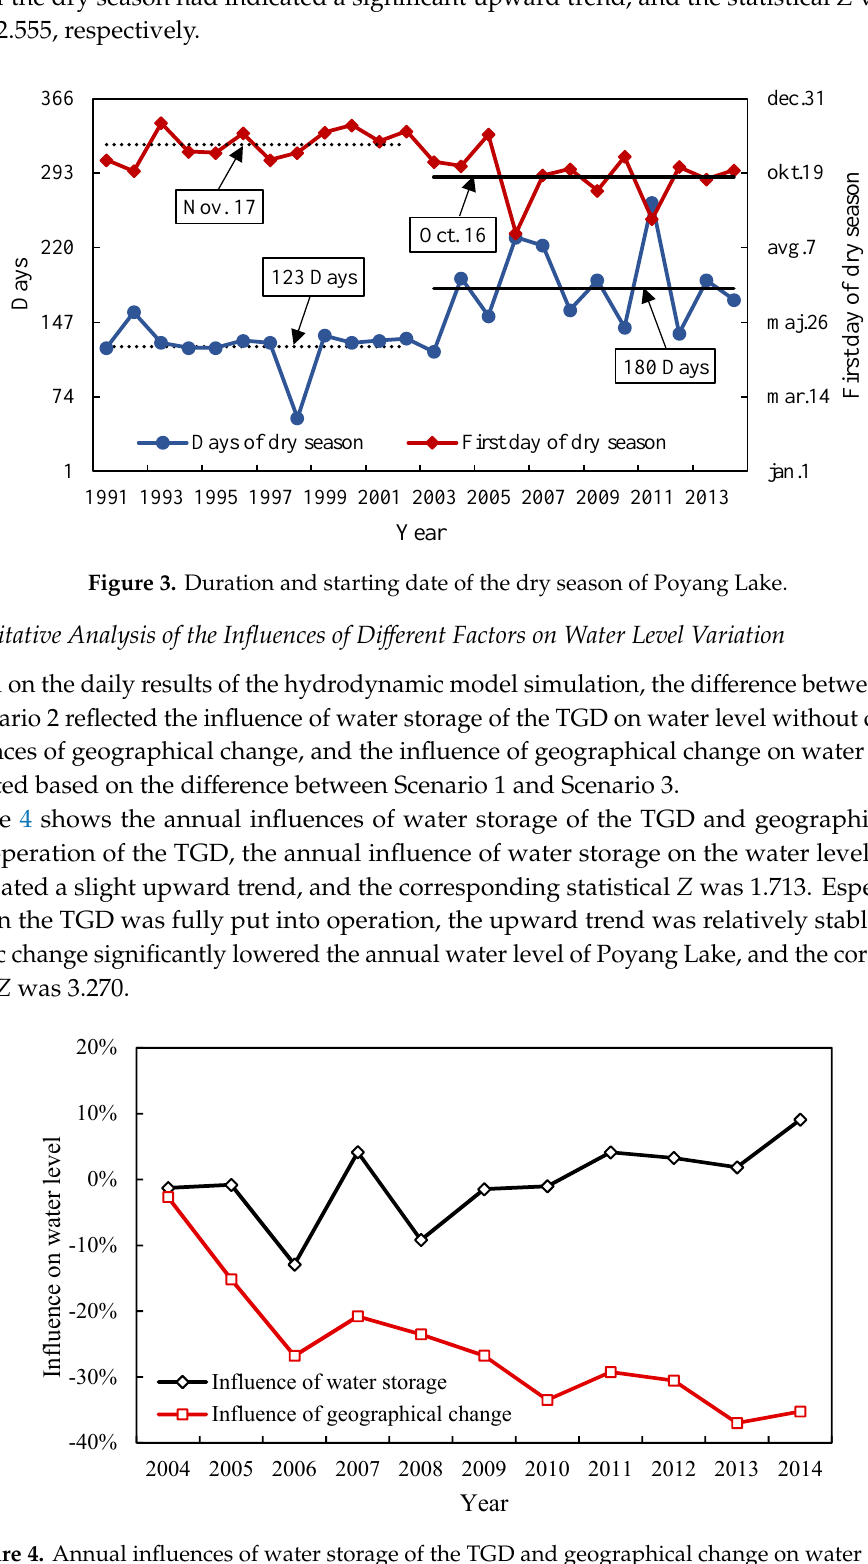
Figure 4. Annual influences of water storage of the TGD and geographical change on water level.